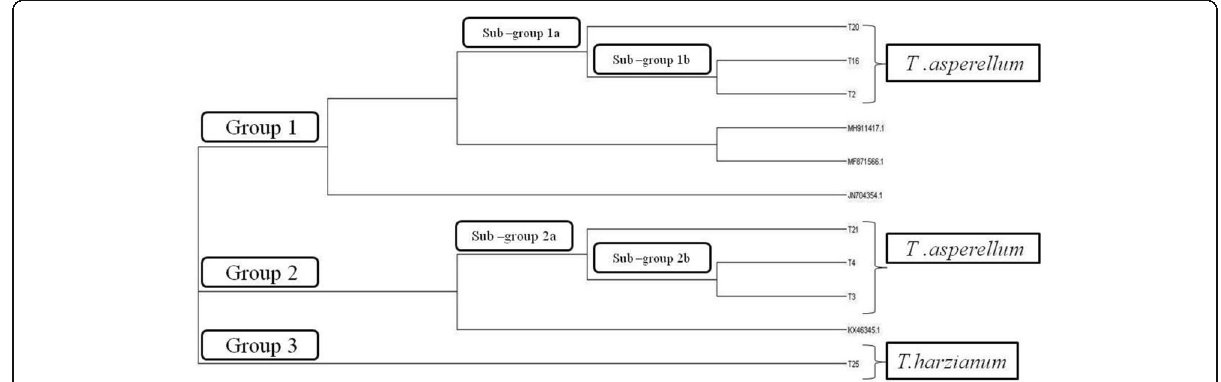
Fig. 3 Dendrogram showing similarity coefficient of seven Trichoderma isolates based on sequencing